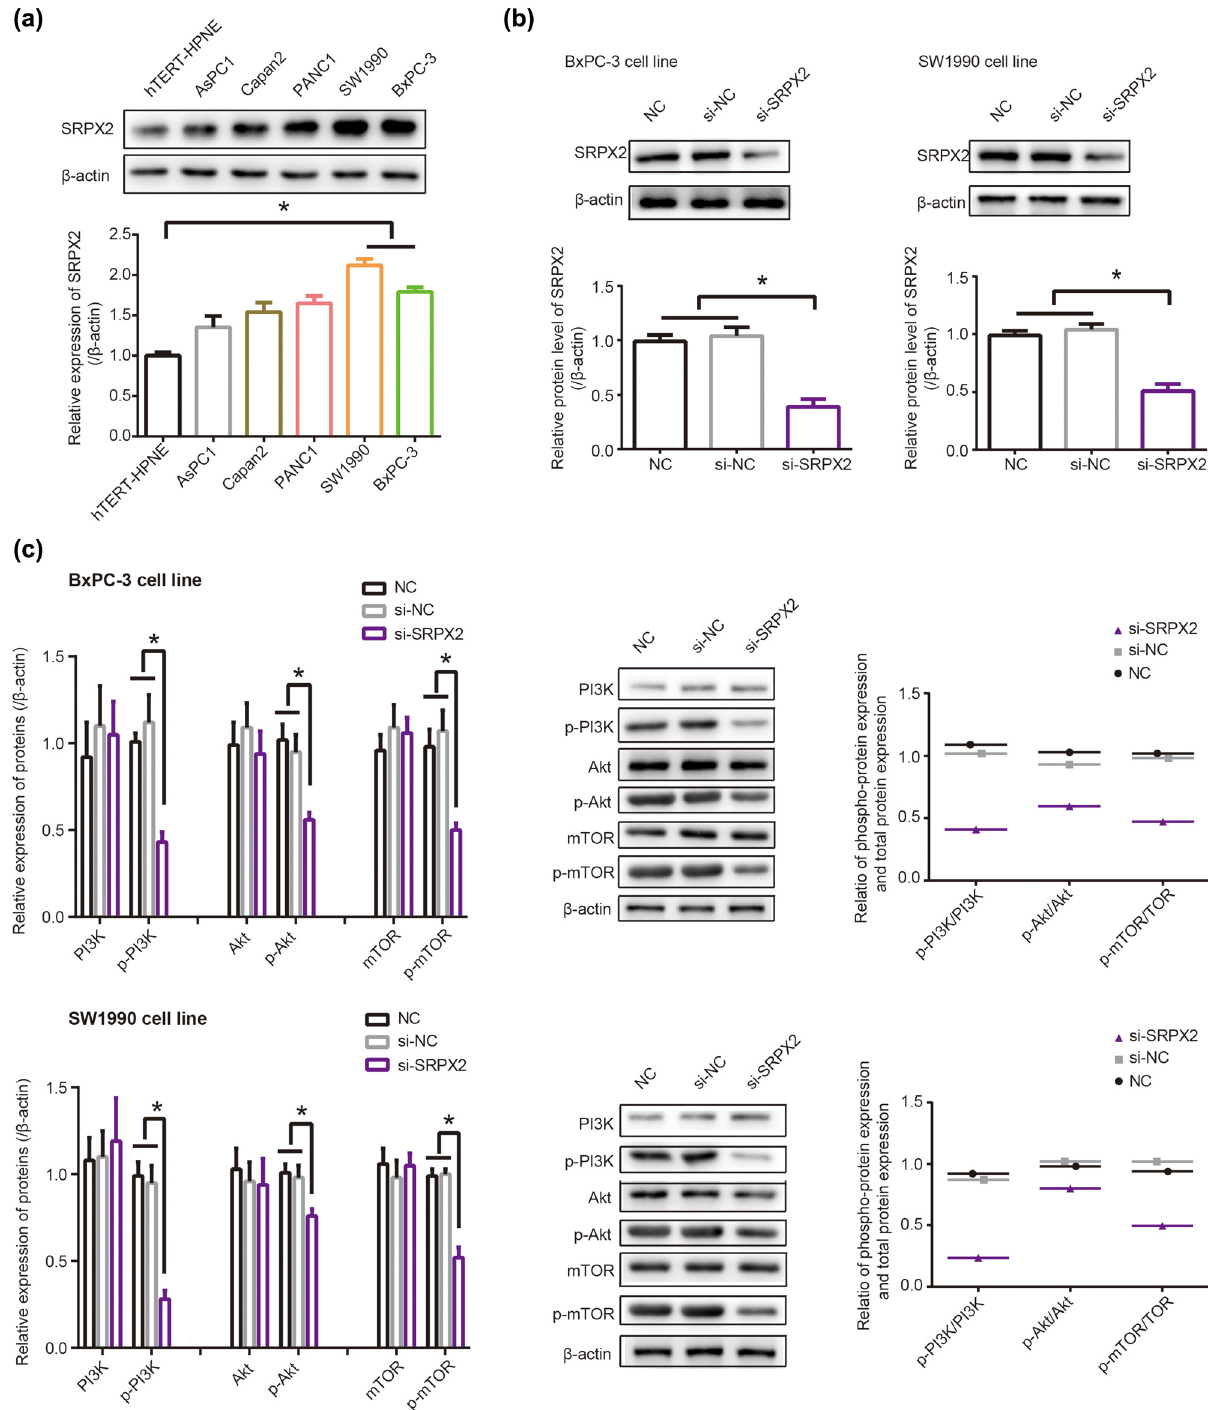
Figure 3: In fl uence of SRPX2 on PI3K/Akt/mTOR signaling. ( a ) Expression of SRPX2 was compared among hTERT - HPNE, AsPC1, Capan2, PANC1, SW1990 and BxPC - 3 cell lines. * P < 0.05. ( b ) SRPX2 expression in SW1990 and BxPC - 3 cell lines was determined after transfection of si - SRPX2. * P < 0.05. ( c ) Protein levels of PI3K, p - PI3K, Akt, p - Akt, mTOR and p - mTOR were monitored after transfecting si - SRPX2 into SW1990 and BxPC - 3 cell lines. * P <